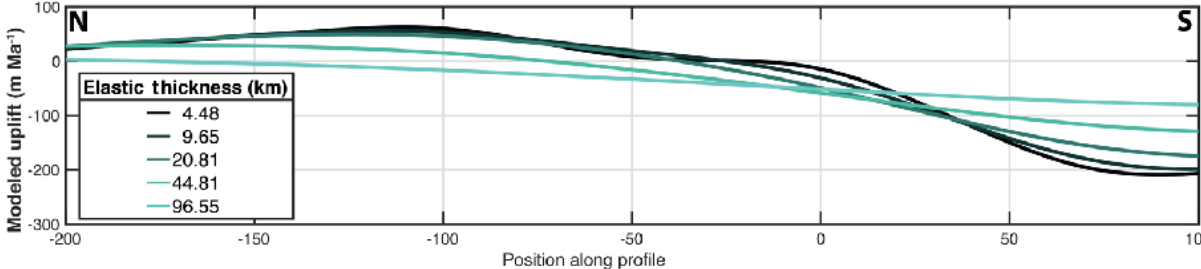
Figure 12. Modeled uplift according to different T e . Most plausible T e are between 10 and 30km.